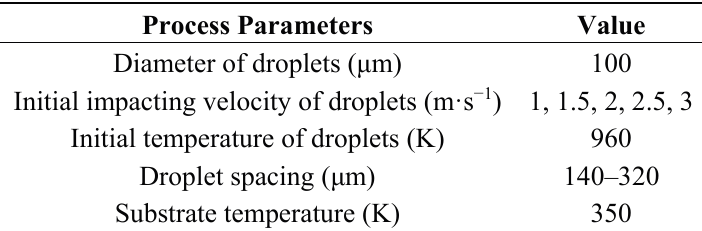
Table 1. Initial conditions.